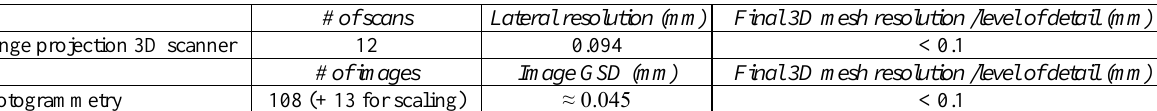
Table 1. 3D digitization of the vase’s geometry with 3D scanning and photogrammetric